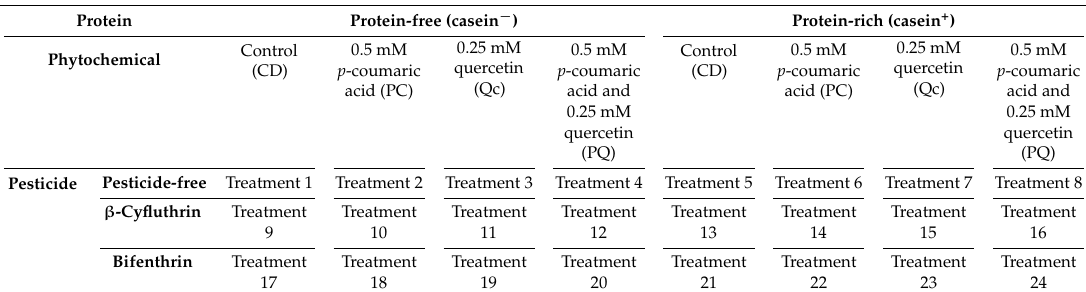
Table 1. Summary of 24 different